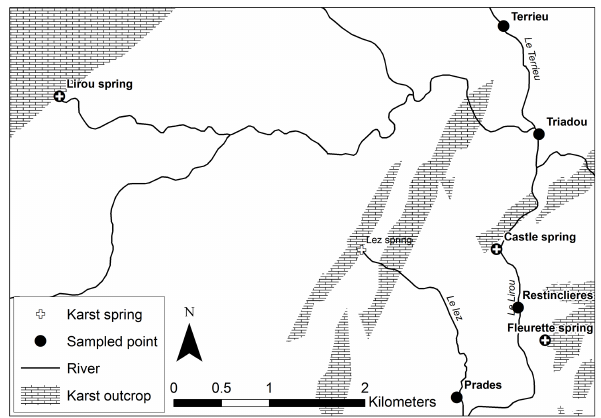
Figure 2. Topographic data used in HEC-RAS, and water trap level on two